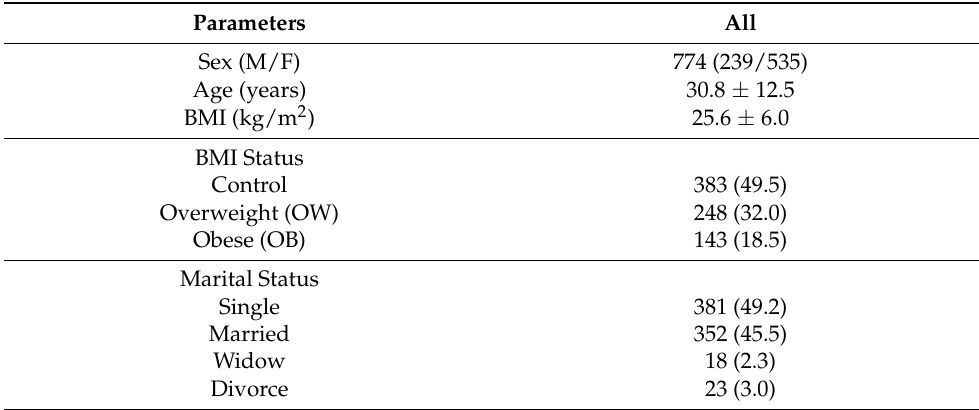
Table 1. Demographic and Anthropometric information of the